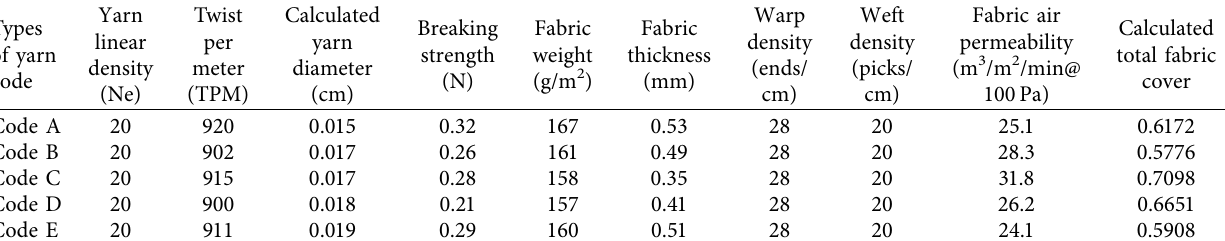
Table 3: Yarn and fabric